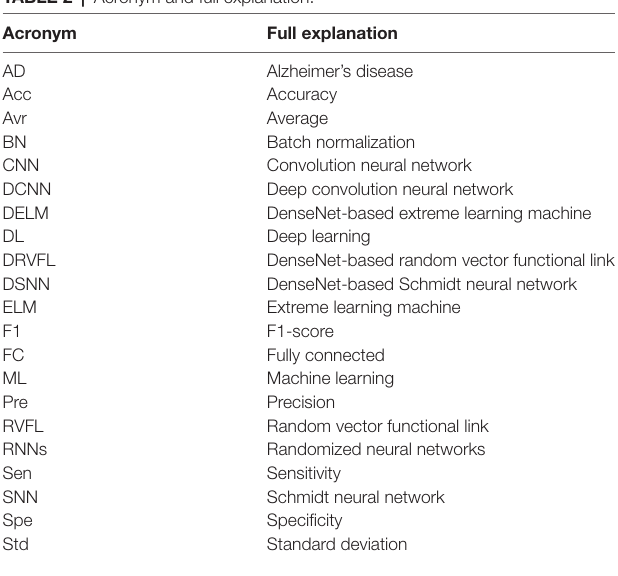
TABLE 2 | Acronym and full